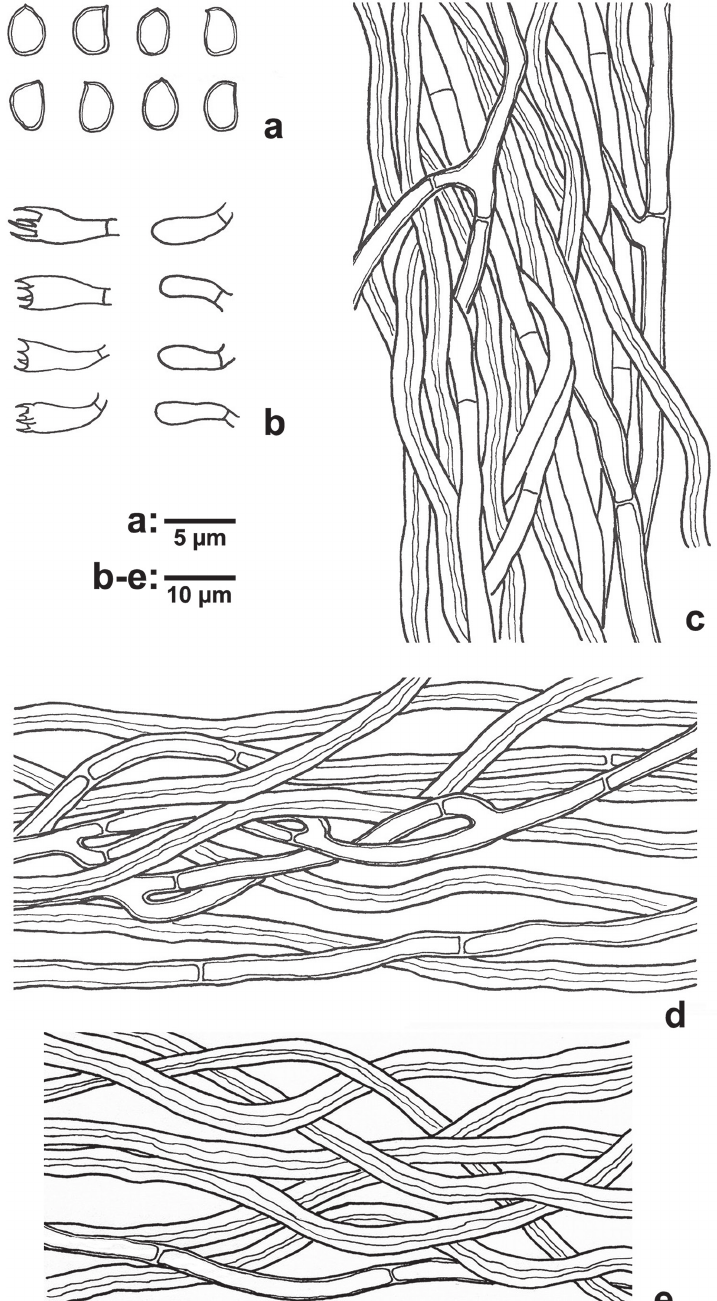
Figure 3. Microscopic structures of Phylloporia lonicerae (drawn from the holotype, LWZ 20170703-2). a Basidiospores b Basidia and basidioles c Hyphae from trama d Hyphae from lower context e hyphae from upper tomentum. Scale bars: a = 5 µm, b–e = 10